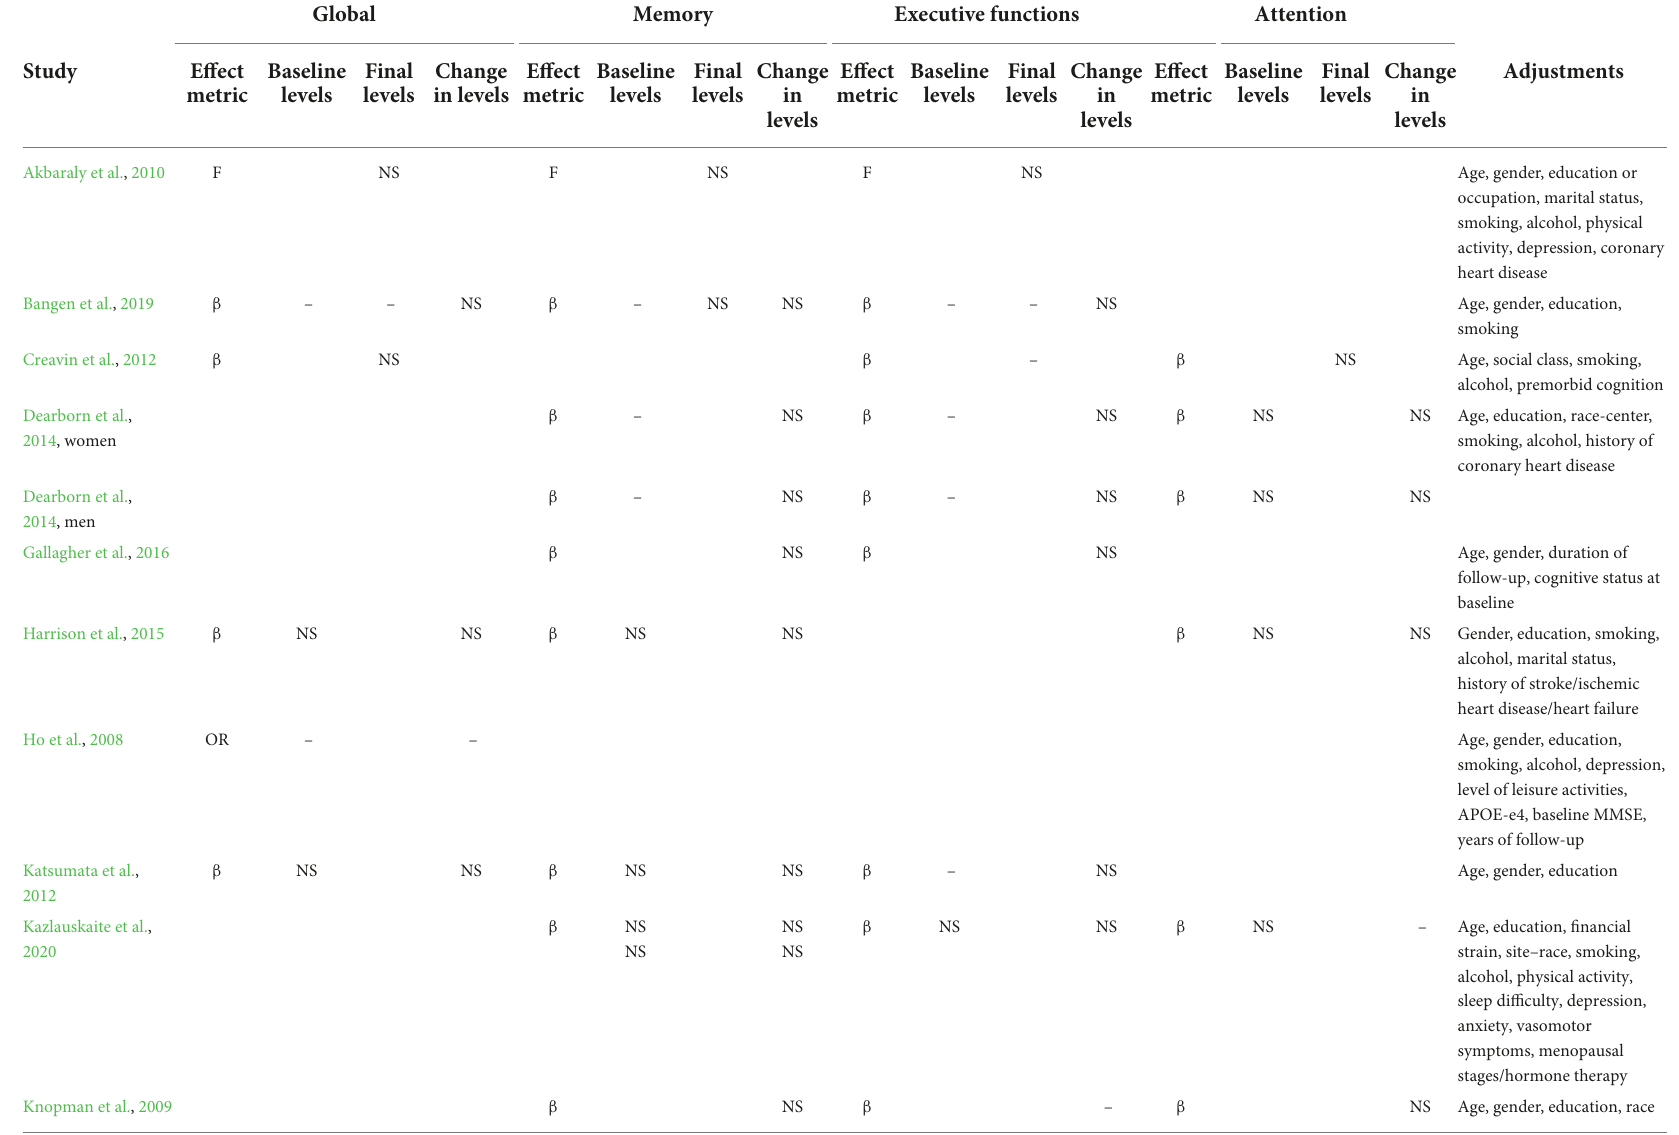
TABLE 3 Summary of the results by cognitive domain, effect metric and adjustments of the included studies.